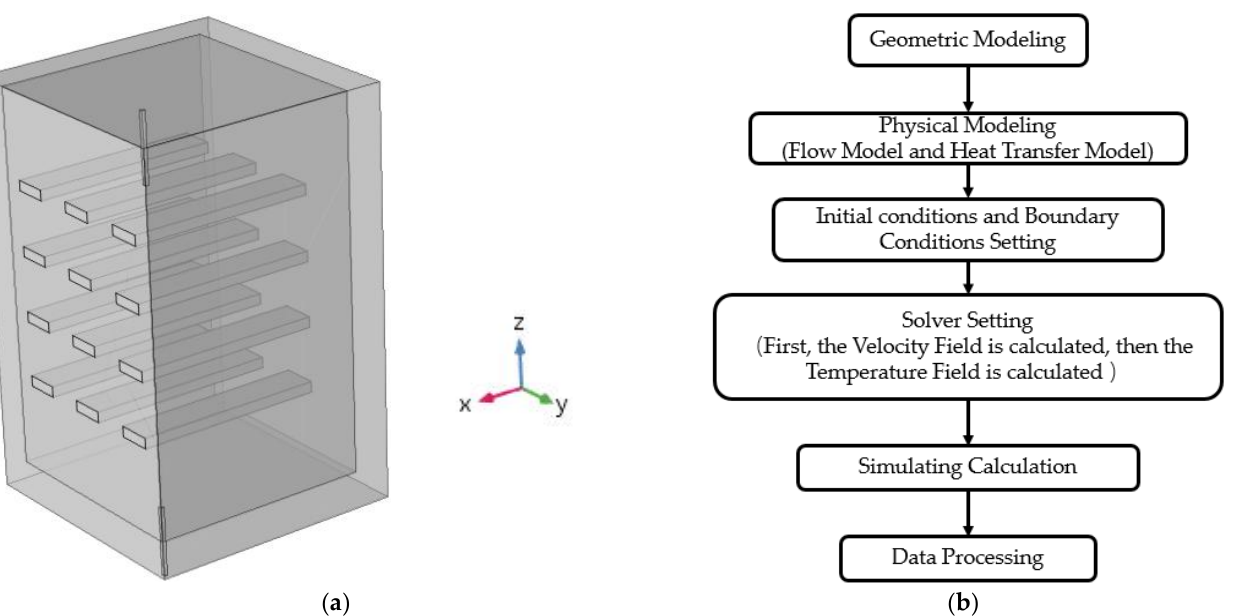
Figure 3. Simulation calculation model and simulation process. ( a ) Simulation calculation model; and ( b ) Detail simulation flowchart.